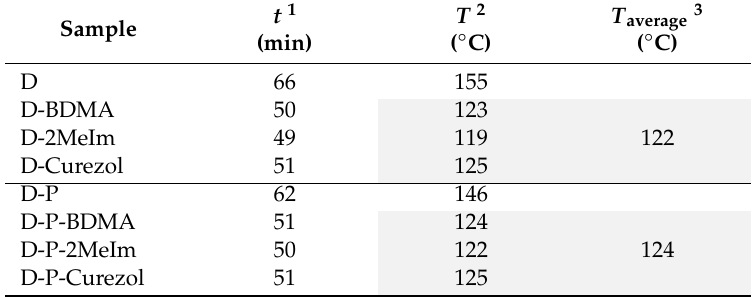
Figure 8. Rheological characterization formulations during thermal curing: ( A ) D-P-based and ( B ) D-based formulations. Table 2. Rheological characterization of D-P-accelerator formulations used for the preparation of coatings.